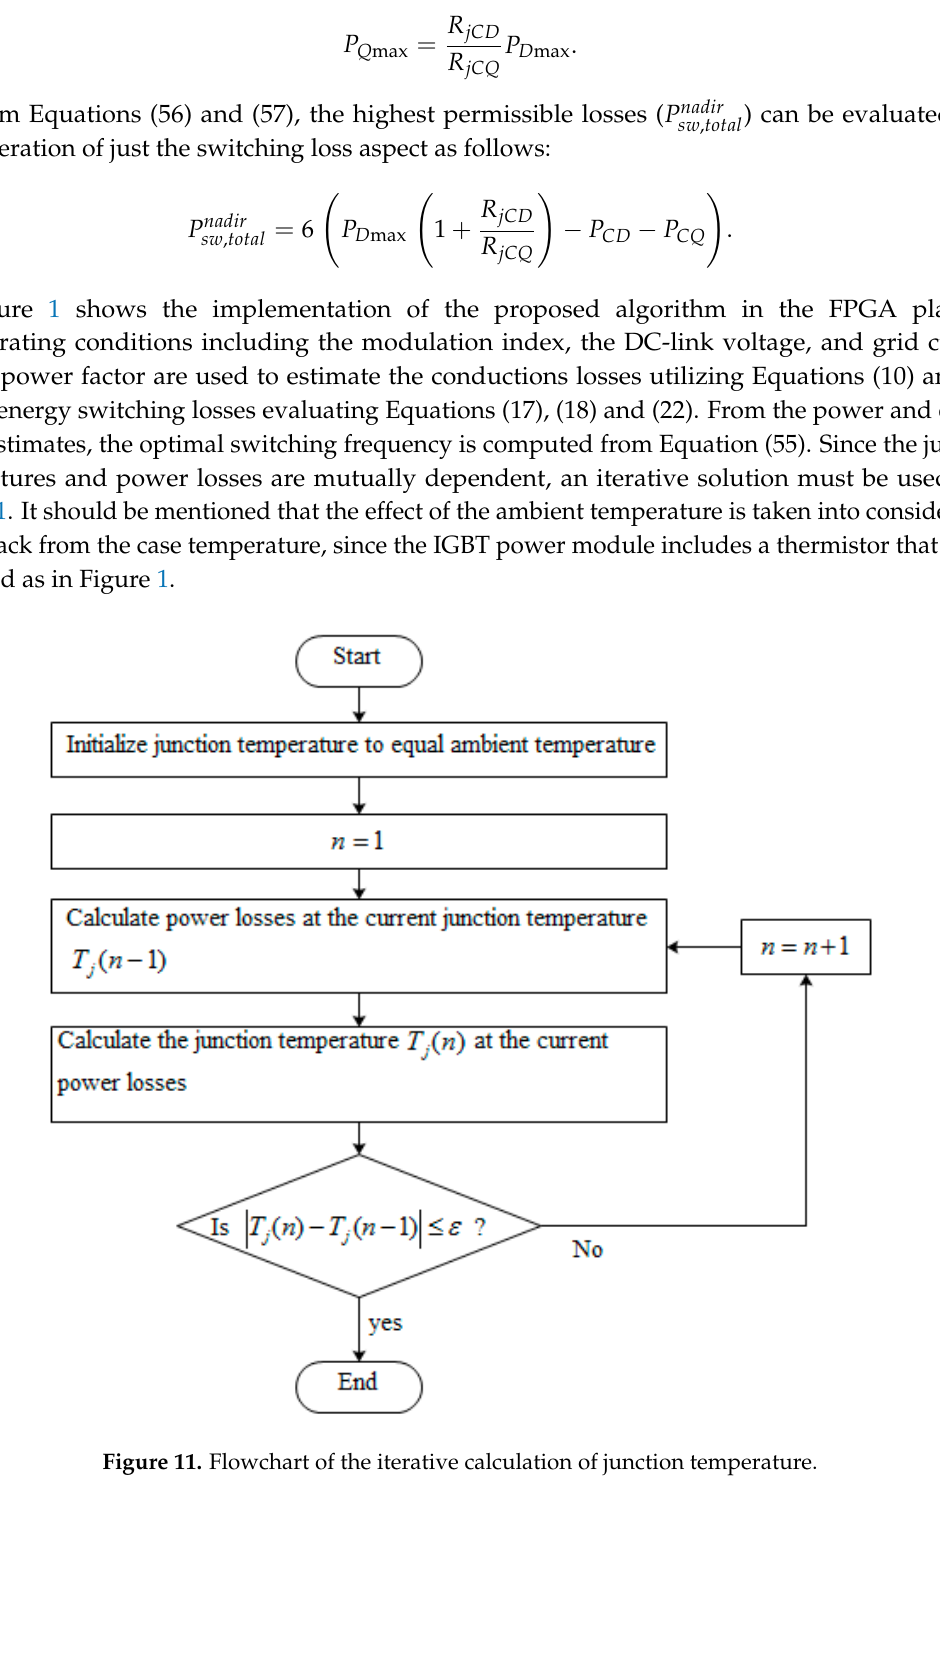
FP50R06KE3) cascaded with passive low pass inductor and capacitor (LC) filter output and